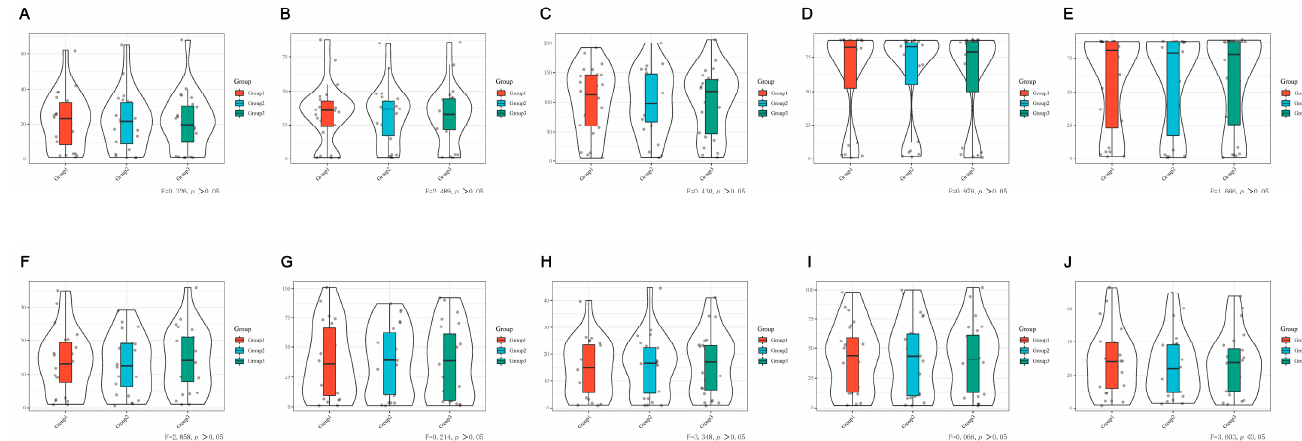
Figure 5. Consistency of the MDIVQAS for repeated measures to assess hand functions. ( A ) Wrist flexion and ulnar deviation; ( B ) Wrist dorsiextension; ( C ) Finger adduction and abduction; ( D ) Forearm pronation; ( E ) Forearm supination; ( F ) Cylindrical grip; ( G ) Spherical grip; ( H ) Thumb abduction; ( I ) Thumb flexion and extension; ( J ) Thumb rotation.